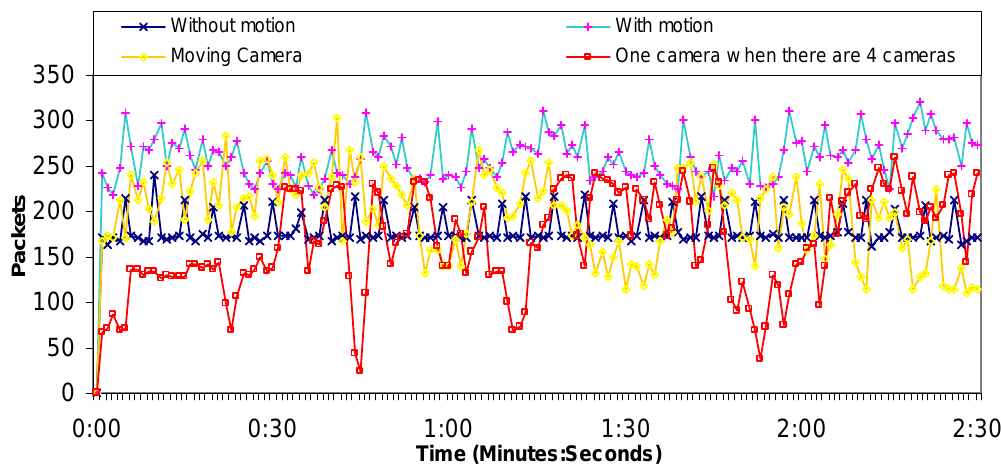
Figure 13. Packets per second obtained by the four situations.